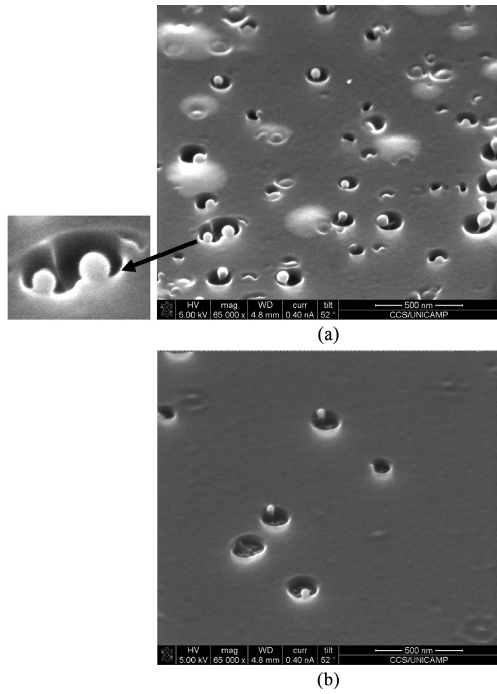
Figure 5. SEM images of structures grown at 70 mTorr C 3 nm Ni (a) and Cu (b) catalytic films.(Samples 70Ni and 70Cu). The inset is a magnified picture of the region showing two nanotubes growing from the nanohole resulting from coalescence of two holes.